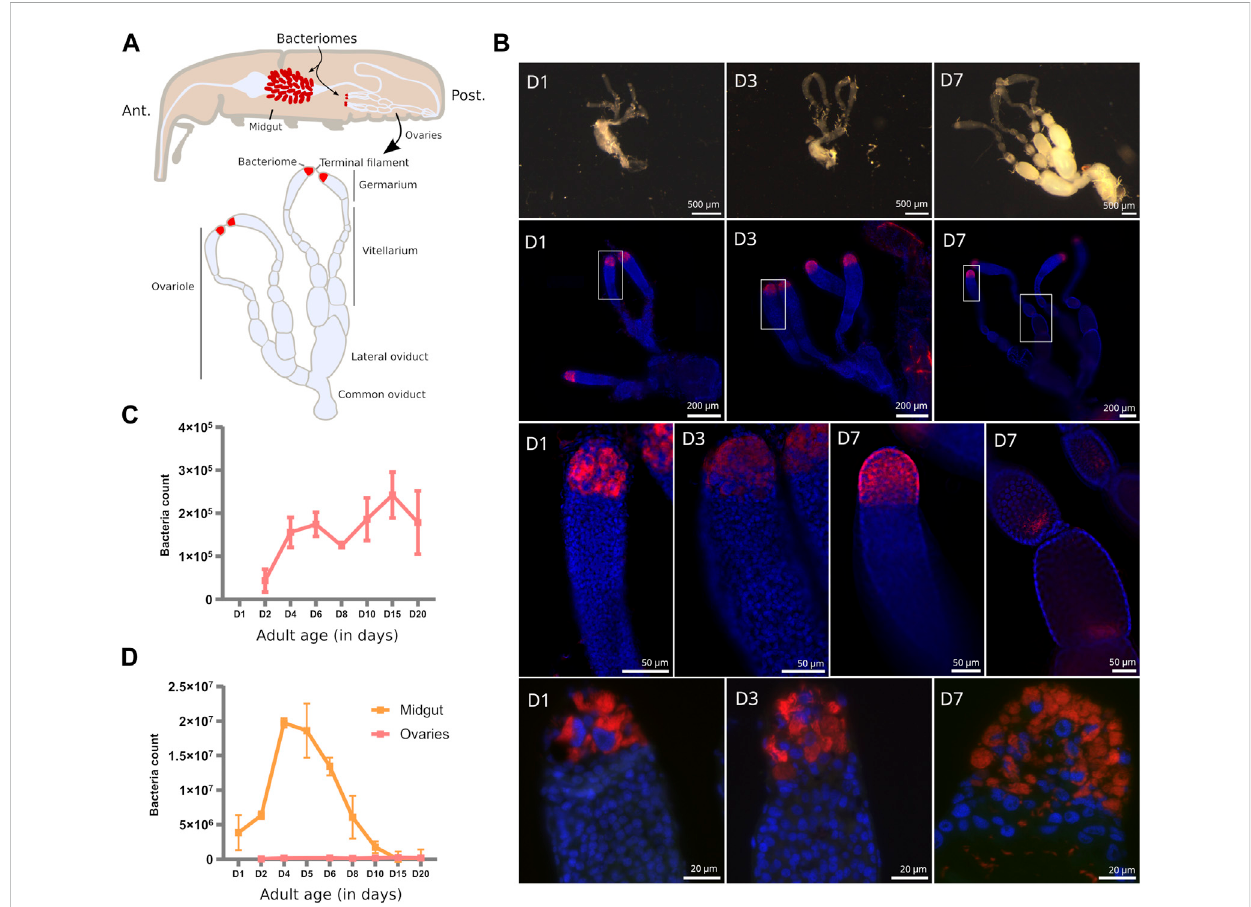
FIGURE 1 Endosymbiont localization and quanti fi cation in S. oryzae ovaries. (A) Scheme of S. oryzae adult showing midgut and ovarian bacteriomes, along withaschemeofovariesbasedonobservationandpreviousreports(Perez-Mendozaetal.,2004;Nardon,2006). S.oryzae harbourstwoovarieswithtwo ovarioles each, composed of a germarium, a vitellarium, lateral oviducts and common oviducts. (B) Upper panel: imaging of adult female reproductive system from day-one-old females (D1 – D7). In agreement with previous observations, S. oryzae ovaries are fully developed in one-week-old females. Middlepanel (second and third lines): whole-mount immuno fl uorescence againstendosymbionts inD1, D3, and D7 ovaries, show thepresence ofbacteria intheovarianapexes,atthebacteriomes,andalso attheposteriorregion ofoocytes (D7). Rectangles indicate theregionobserved inthethird line. The bottom panel depicts tissue sections of germaria immuno fl uorescence against endosymbionts. The bottom-right image shows bacteria in the germarium, outside of the bacteriome (D7). (C – D) Quanti fi cation of endosymbiont load by fl ow cytometry in ovaries and gut [gut from (Dell ’ Aglio et al., 2023)]. Endosymbiont load increases in the fi rst couple of days in both ovaries and gut bacteriomes, although there are a hundred times more in the gut. After the fi rst week of adulthood, gut endosymbionts are lost while ovarian ones are maintained. (D) depicts the age in